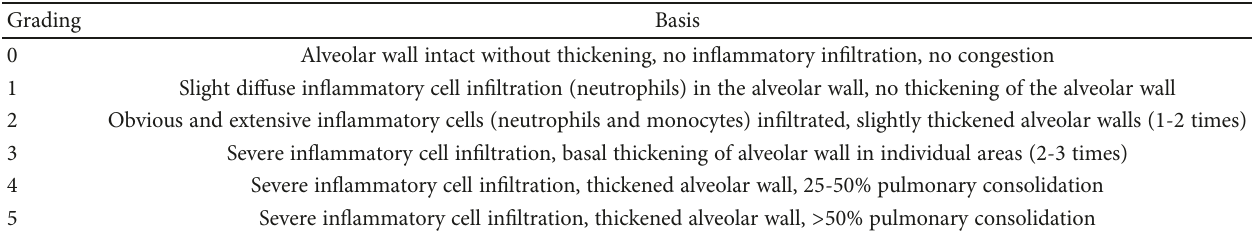
Table 1: Pathology classi fi cation standard of lung injury.